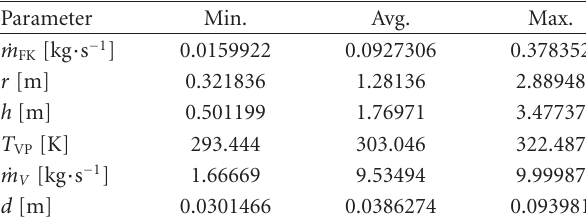
Table 11: Estimated parameters for